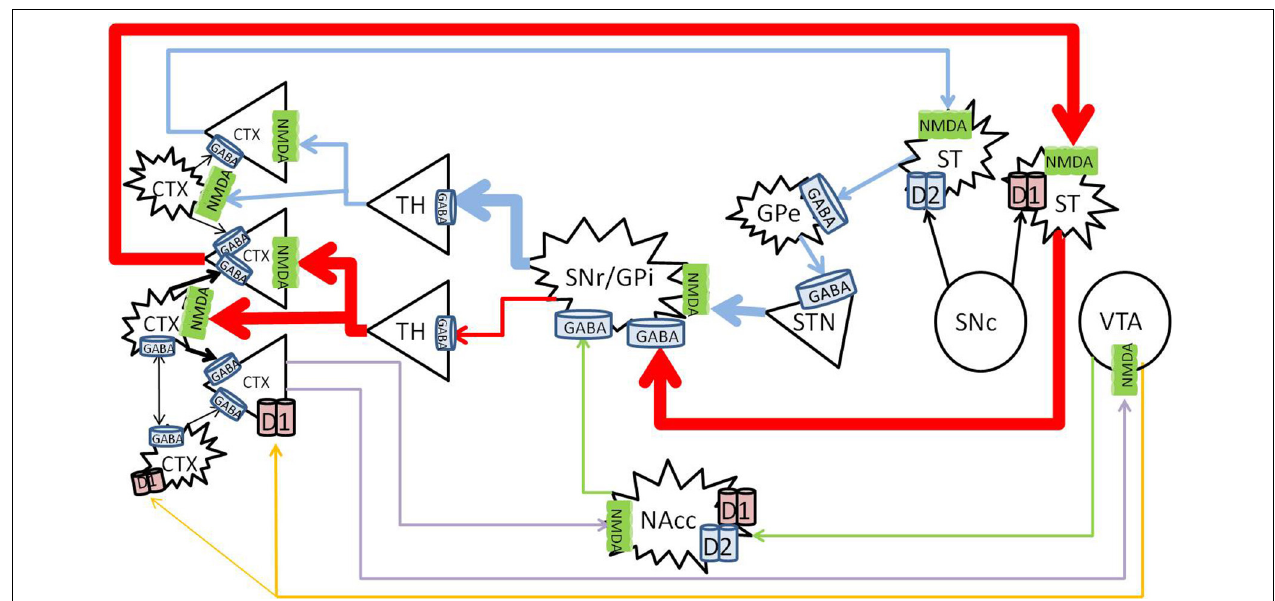
FIGURE 1 | Nigrostriatal, mesocortical, and mesolimbic pathways. When cortical neurons activate the NMDA receptors on neurons of the direct pathway ( red ) in the striatum, striatal neurons are primed to send GABA signals to the SNr/GPi, which would inhibit the tonic GABA to the thalamus, allow glutamate signals to fire in the cortex, and further activate cortical neurons. The indirect pathway ( blue ) is primed when cortical neurons activate the NMDA receptors on the striatal neurons that express D 2 receptors, which would send inhibitory signals to the globus pallidus externa (GPe), reduce GABA signaling to the STN, and stimulate the SNr/GPi to enhance GABA inhibiting of thalamocortical signaling. The mesolimbic pathway ( green ) consist of dopaminergic projections from the VTA to the NAcc, which sends